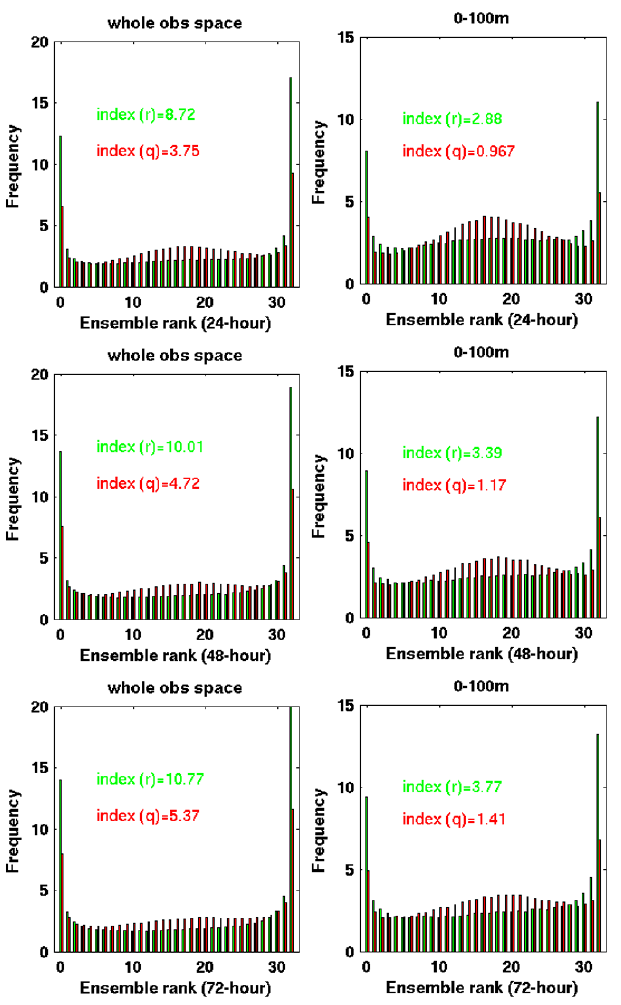
Fig. 6. Talagrand rank histograms for salinity (r: green, q: red) using observation as truth for lead times of 24, 48, and 72h (from top to bottom). All the values are averaged over the 109 day period from 1 June to 17 September 2012, and over the full observation space (left panel), the layer between 0 and 100m (right panel). Consistency index is also indicated in each case for both ensembles.